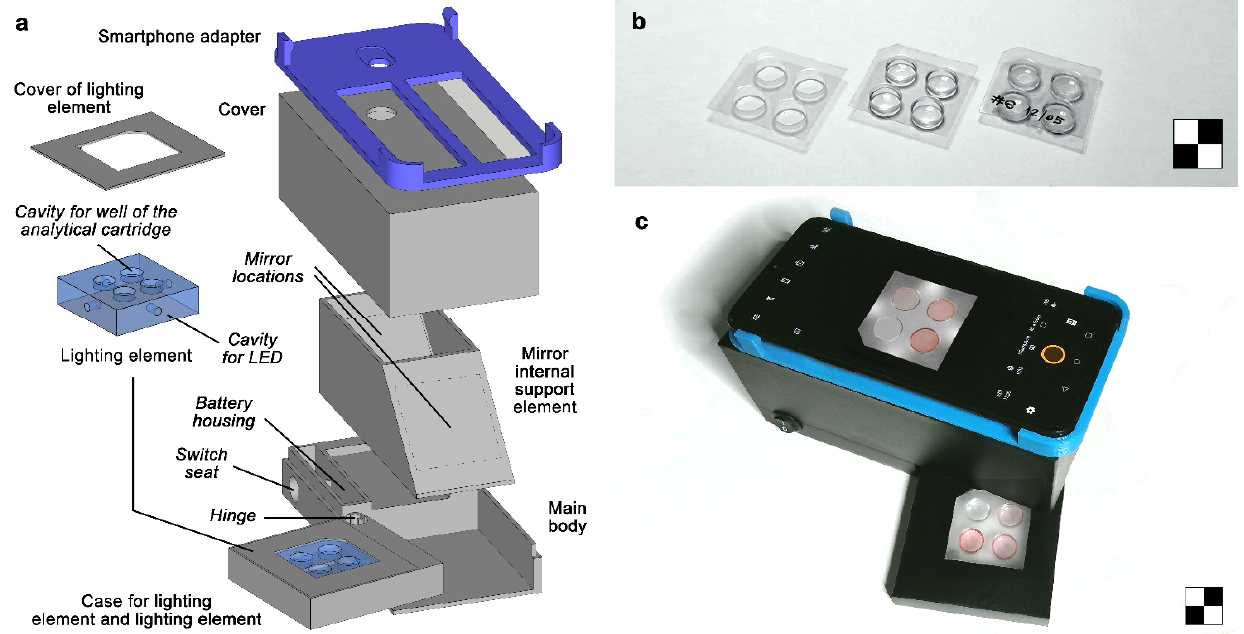
Figure 1. ( a ) Schematic drawing of the 3-D-printed elements of the analytical device (electric components, such as battery, LED control switch, LEDs, and electrical wiring, are not shown); ( b ) From left to right: vacuum-thermoformed analytical cartridge, analytical cartridge filled with the gelled reaction medium, analytical cartridge sealed with the adhesive plastic foil for storage; ( c ) Analytical device connected to the OnePlus 6 smartphone. The checkerboards are 2 × 2 cm.